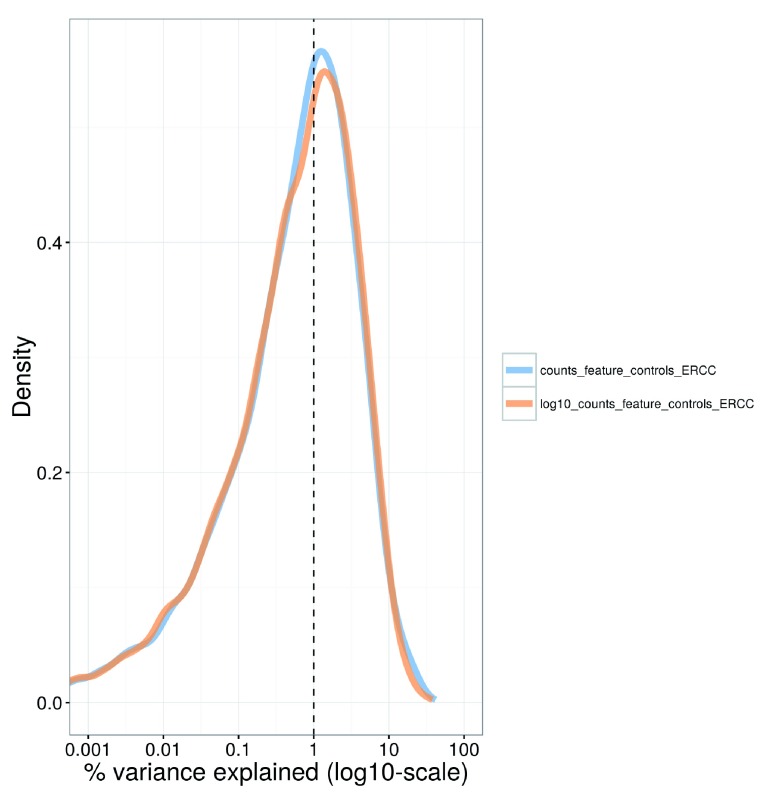
Density plot of the percentage of variance explained by the (log-transformed) total spike-in counts across all genes in the HSC dataset.For each gene, the percentage of the variance of the normalized log-expression values across cells that is explained by each factor is calculated. Each curve corresponds to one factor and represents the distribution of percentages across all genes.